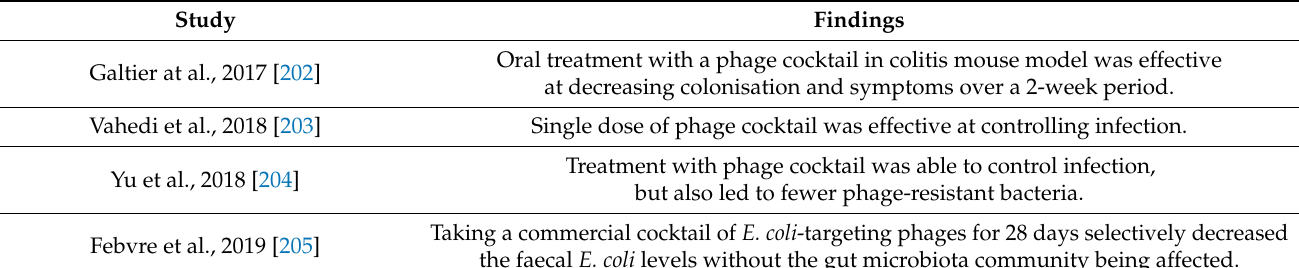
Table 11. Details of studies looking into the efficacy of phage therapy against Escherichia coli . Study Findings Oral treatment with a phage cocktail in colitis mouse model was effective Galtier at al., 2017 [202] at decreasing colonisation and symptoms over a 2-week period. Vahedi et al., 2018 [203] Single dose of phage cocktail was effective at controlling infection. Treatment with phage cocktail was able to control infection, but also led to fewer phage-resistant